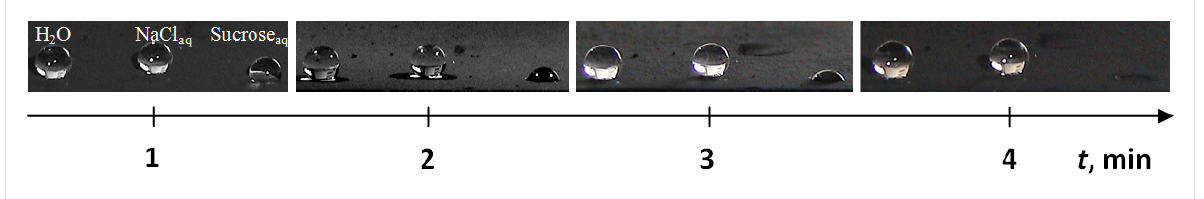
Figure 2: Sequence of images showing infiltration of the HACNT film, as grown on the quartz substrate, by different aqueous solutions. Each image contains a droplet of water (left), saturated saline solution (centre) and saturated sucrose aqueous solution (right).